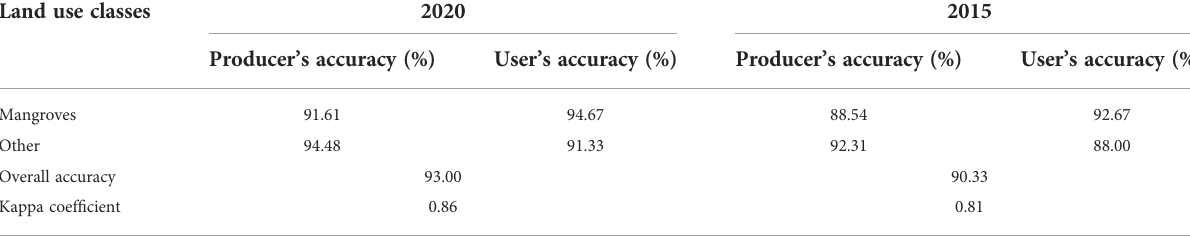
TABLE 1 Accuracy metrics for land cover classi fi